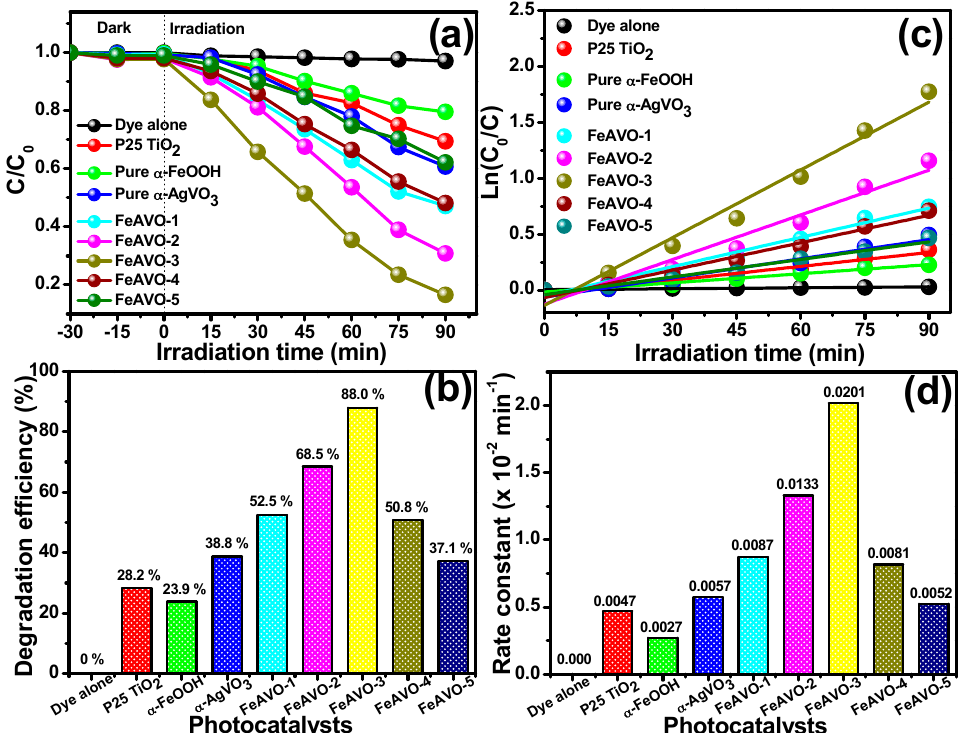
Figure 8. ( a ) Photodegradation plots, ( b ) the degradation efficiency, ( c ) first-order kinetics plots and ( d ) the rate constant values of the pure α -FeOOH, pure α -AgVO 3 and different α -FeOOH/ α -AgVO 3 nanocomposite photocatalysts for the degradation of Rhodamine B (RhB) under visible-light